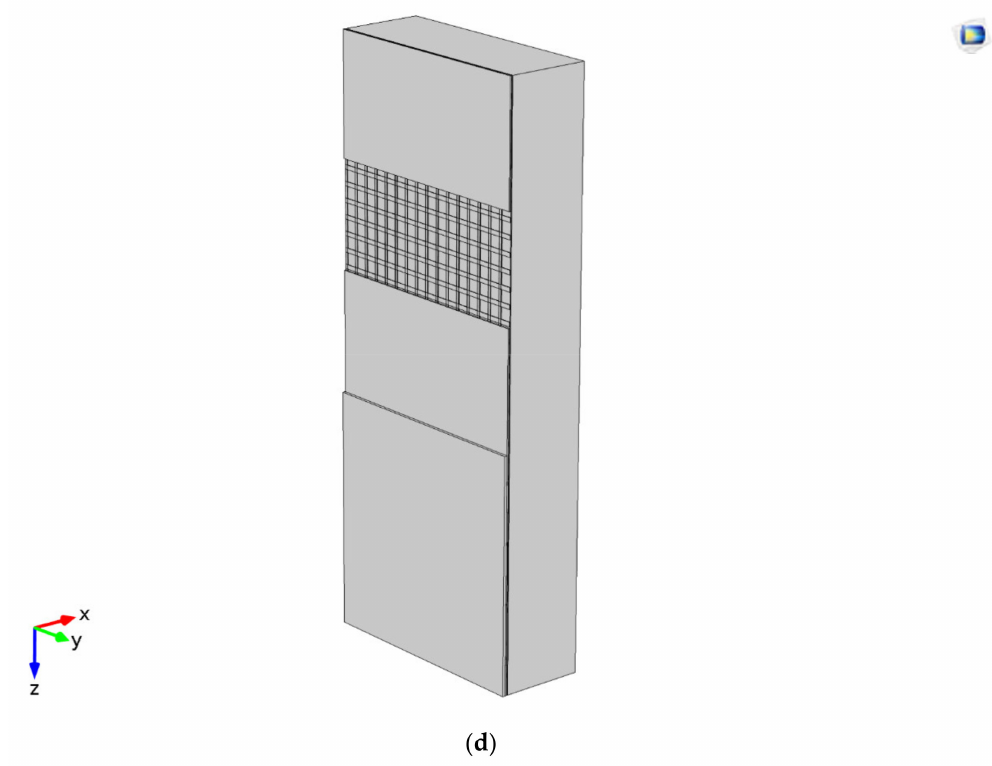
Figure 1. ( a ) Test specimen (front view); ( b ) test specimen (lateral view) along with the plane section linked to Figure 17a; ( c ) numerical model involving surface thermal loading; ( d ) the specimen built in Comsol Multiphysics ®